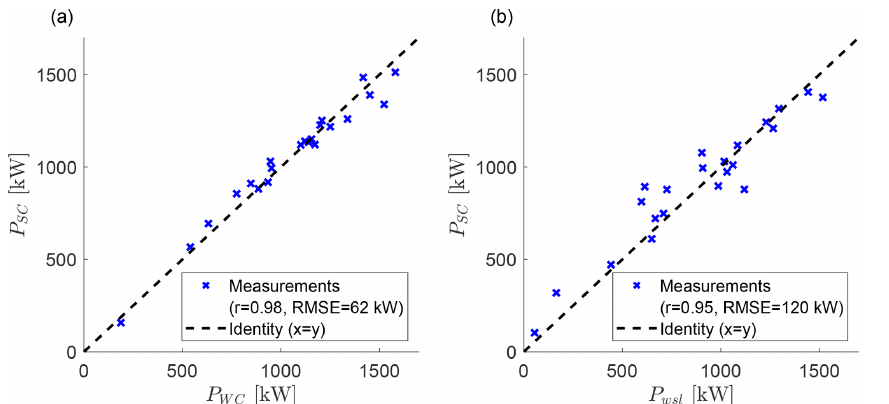
Figure 10. Comparison of the power from the SCADA data and the power estimated from the Doppler lidar measurements for T2 (a) and T3 (b) using the wake-steering cases with a 3D scan of wake-scanning lidar and a model prediction at x/D = 4. Blue crosses show the measurement data, and the dashed black line is the identity ( y = x ).